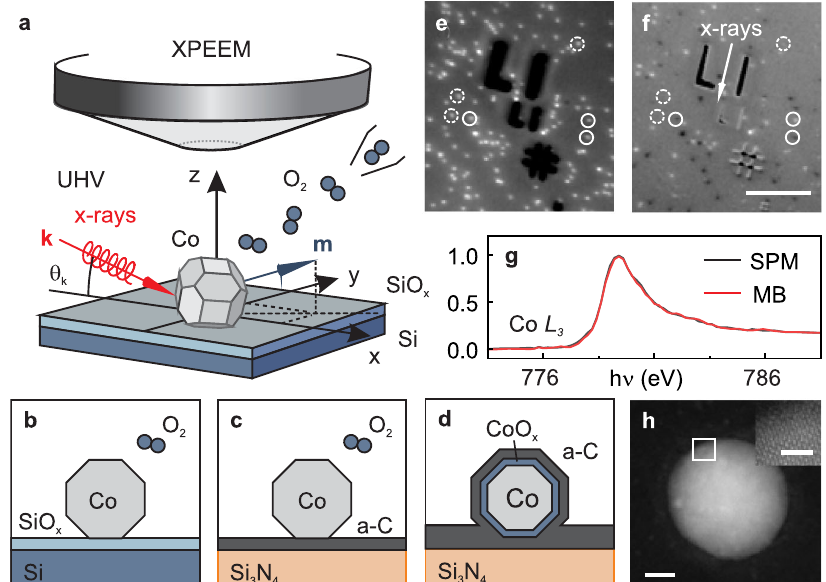
Fig.1|Insitux-rayphotoemissionelectronmicroscopy(XPEEM)investigation. a Schematic of the XPEEM setup for the in situ oxidation of Co nanoparticles by means of molecular oxygen dosing under ultrahigh vacuum (UHV) conditions. b – d Illustration of the samples under investigation: b Co nanoparticles on Si/SiO x wafers, c on electron transparent Si 3 N 4 -membranes covered with an amorphous carbon (a-C) layer, and d upon capping with an additional a-C layer for transfer to the high-angle annular dark- fi eld scanning transmission electron microscopy (HAADF-STEM) instrument. e XPEEM elemental and f respective x-ray magnetic circulardichroism(XMCD)contrastmapofConanoparticlesinthepristinemetallic